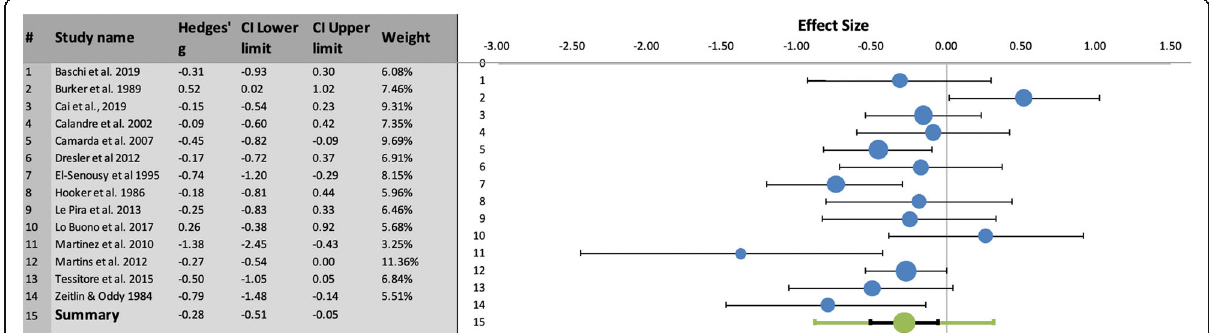
Fig. 2 Left: Summary results of meta-analysis regarding TMT-A performance differences between migraine patients and healthy controls, including Hedges ’ g, Confidence Intervals (CI) and relative weight of each study. Right: Forest plot showing the effect size (with confidence interval) of individual studies and, below, the combined effect size with its confidence interval (in black) and its prediction interval (in green)